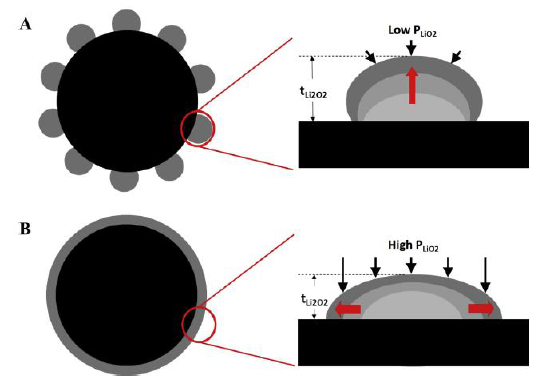
Figure 12. An illustration of Li 2 O 2 formation at different discharge current densities. ( A ) Island-like deposition at low current densities; and ( B ) plate-like deposition at high current densities. Reprinted from Jung et al. [21], with permission from Elsevier.